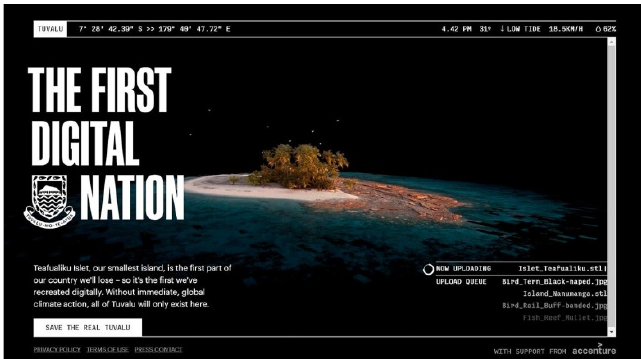
Figure 2: Tuvalu’s official website showing real-time live updates of nation’s heritage being uploaded on the metaverse: